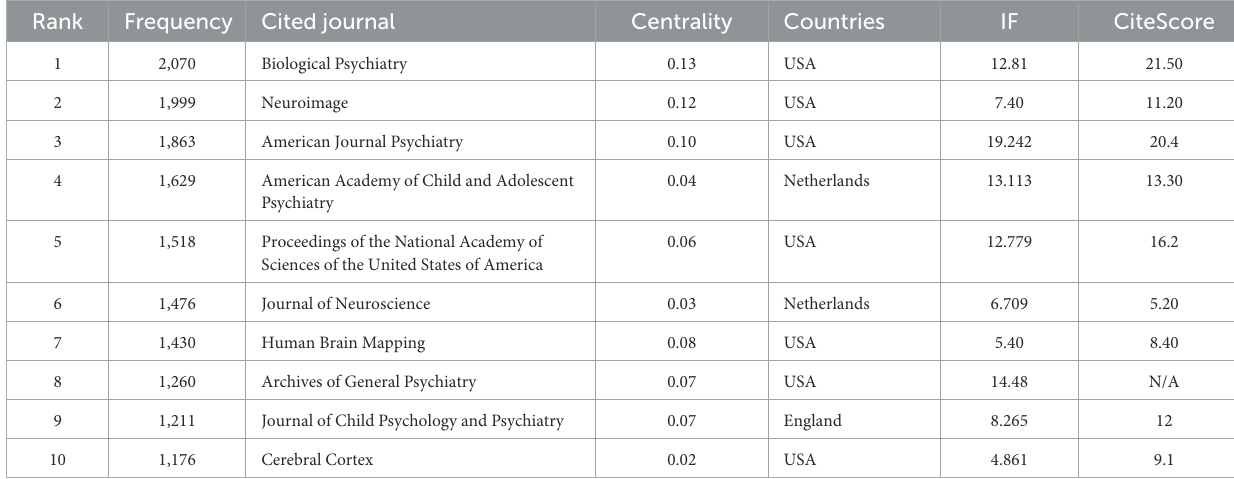
TABLE 6 Top 10 cited journals related to ADHD